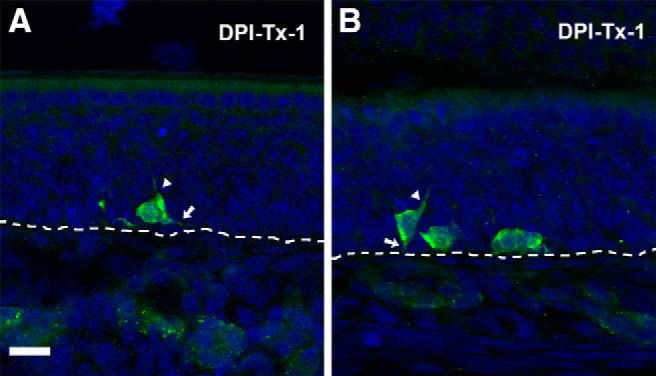
In vivo genetic fate-mapping strategy reveals no evidence of polarity in P25-born OSNs. A, B, ZsGreen+ cell bodies lying on the basal lamina (dashed line) at DPI-Tx-1. Initial extension of the apical dendrite (arrowhead) and axon (arrow). Scale bar, 20 μm.